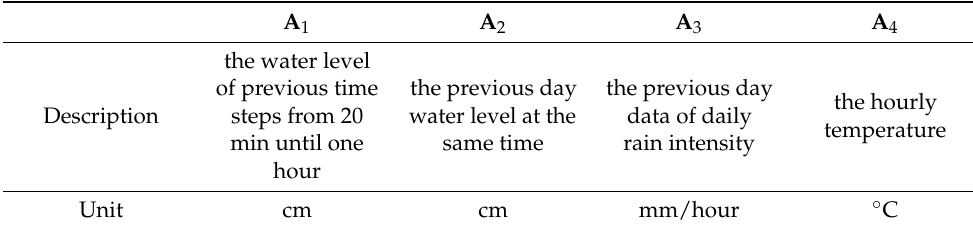
Table 6. The exogenous variables with the ANN forecast model (Model